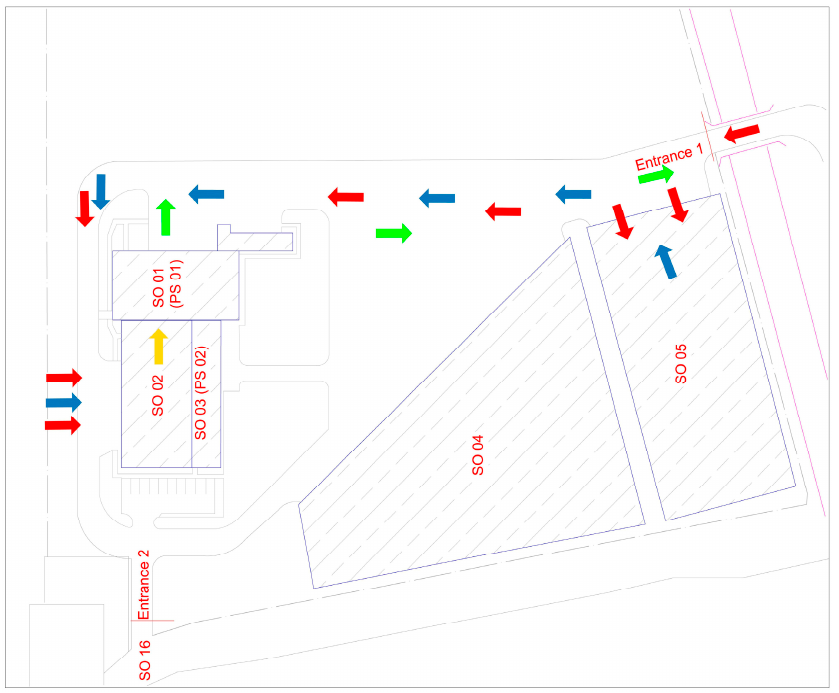
Figure 4. The direction of the straw handling (source: by authors).